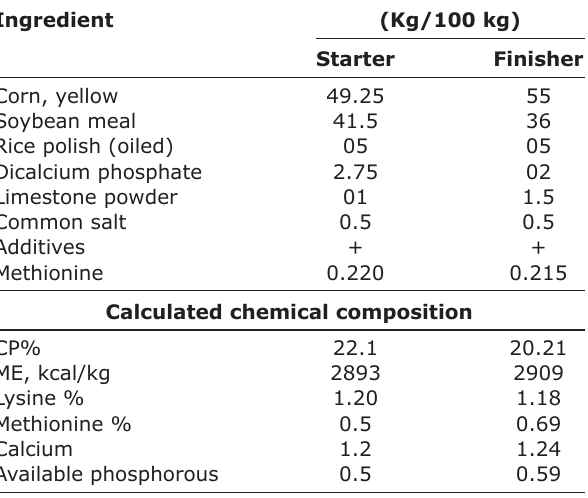
Table-1: Ingredient composition of broiler starter and finisher rations.